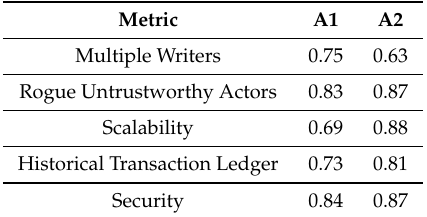
Table 7. Metric comparison for A1 and A2.